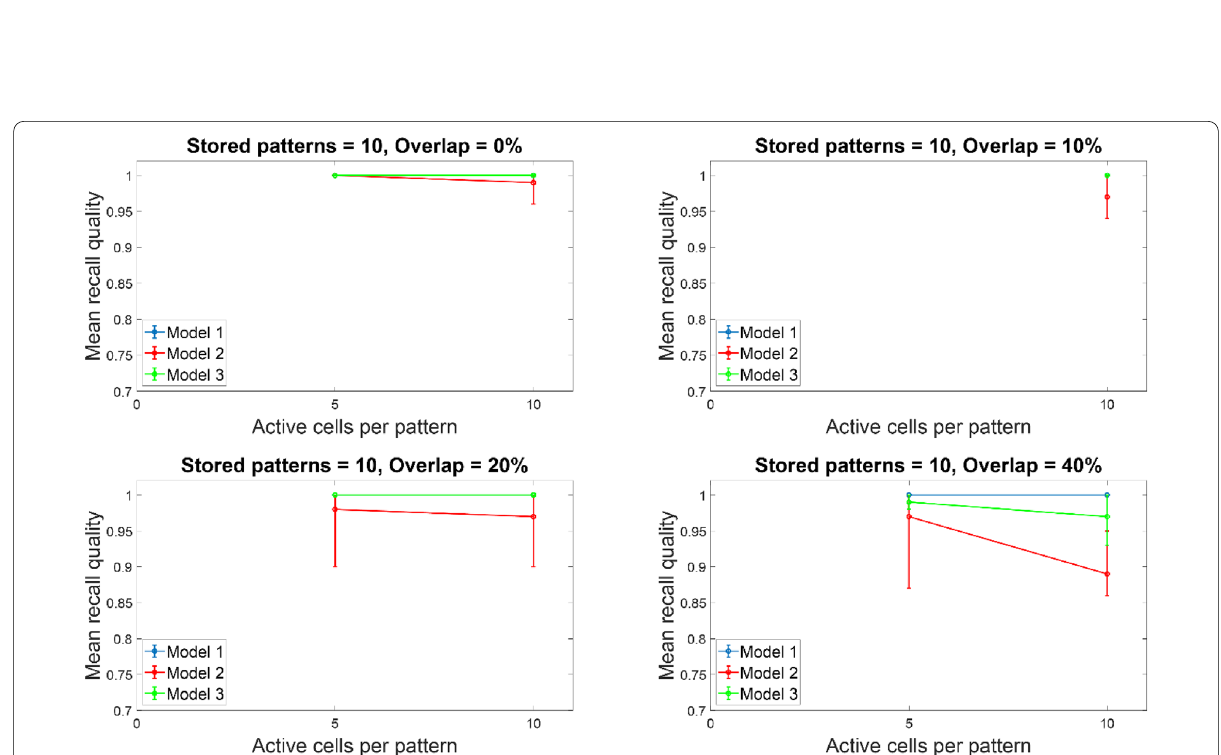
Fig. 11 Mean recall quality of ‘model 1’, ‘model 2’, and ‘model 3’ as a function of active cells per pattern (5, 10, 20) when ten patterns were stored with various percentages of pattern overlap. Each model was a network of 100PCs, one BSC,, and one OLM